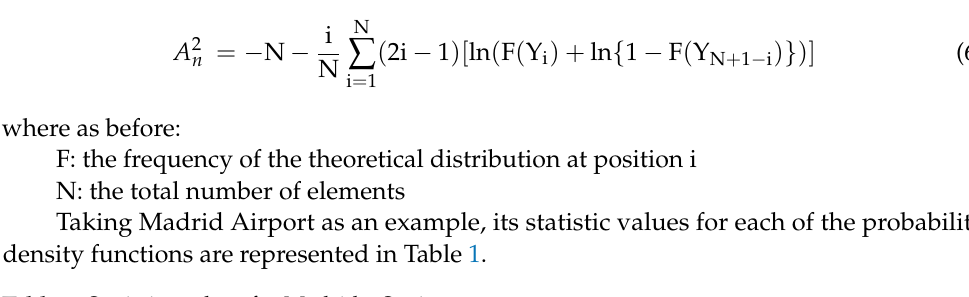
Table 1. Statistics values for Madrid—Spain.